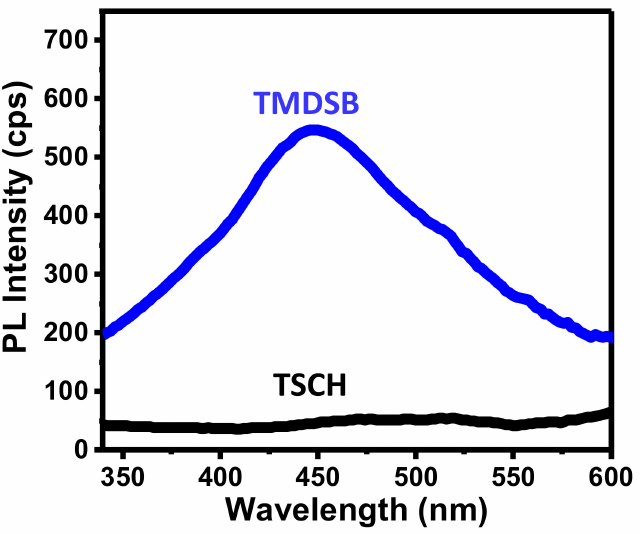
Figure 10. Photoluminescence (PL) measurements for as-deposited SiC films generated using TSCH versus SiC films deposited using TMDSB.